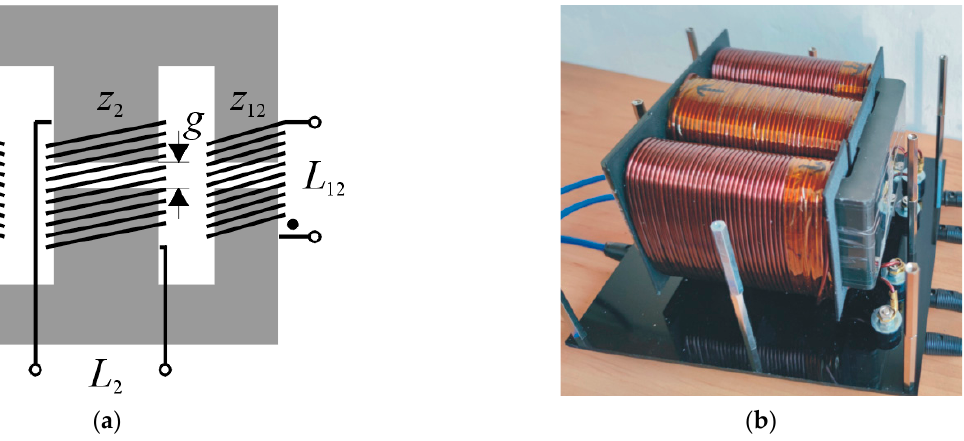
Figure 4. Details of the tuned inductor design ( a ) and its general view ( b ).